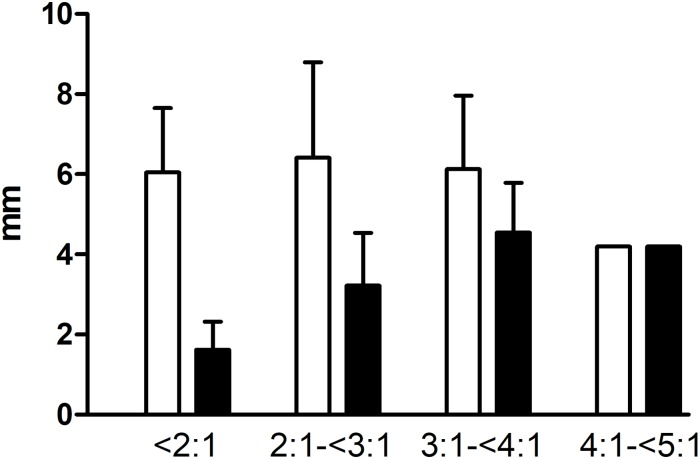
100 abdominal midline closure measurements in dogs categorized by SL:WL ratios <2:1, 2:1-<3:1, 3:1-<4:1, and 4:1-<5:1 analyzed for the mean SI ± SD and mean TB ± SD.